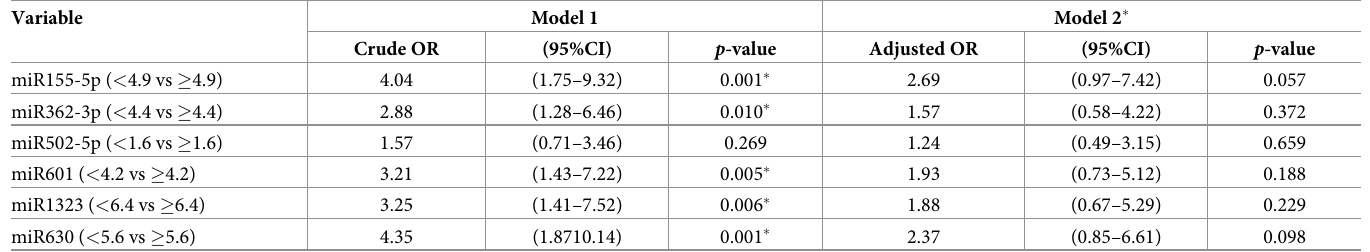
Table 4. Analysis of biomarkers associated with severe